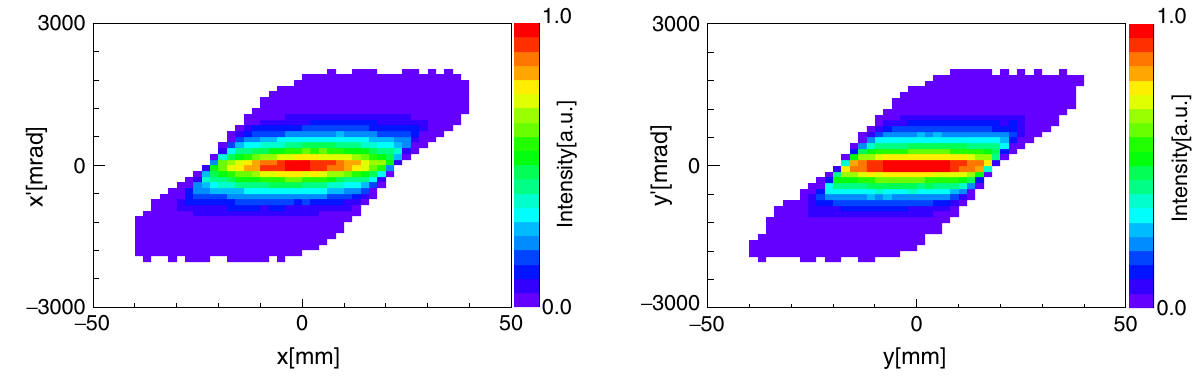
FIG. 5. Simulated phase-space distributions of the Mu − ion beam on the downstream surface of the Al target. The top and the bottom figures show the horizontal and vertical phase spaces, respectively. The number of generated events is 10 6 events. The average kinetic energy of the Mu − ions was selected: 1 keV( βγ ¼ 0 . 0044